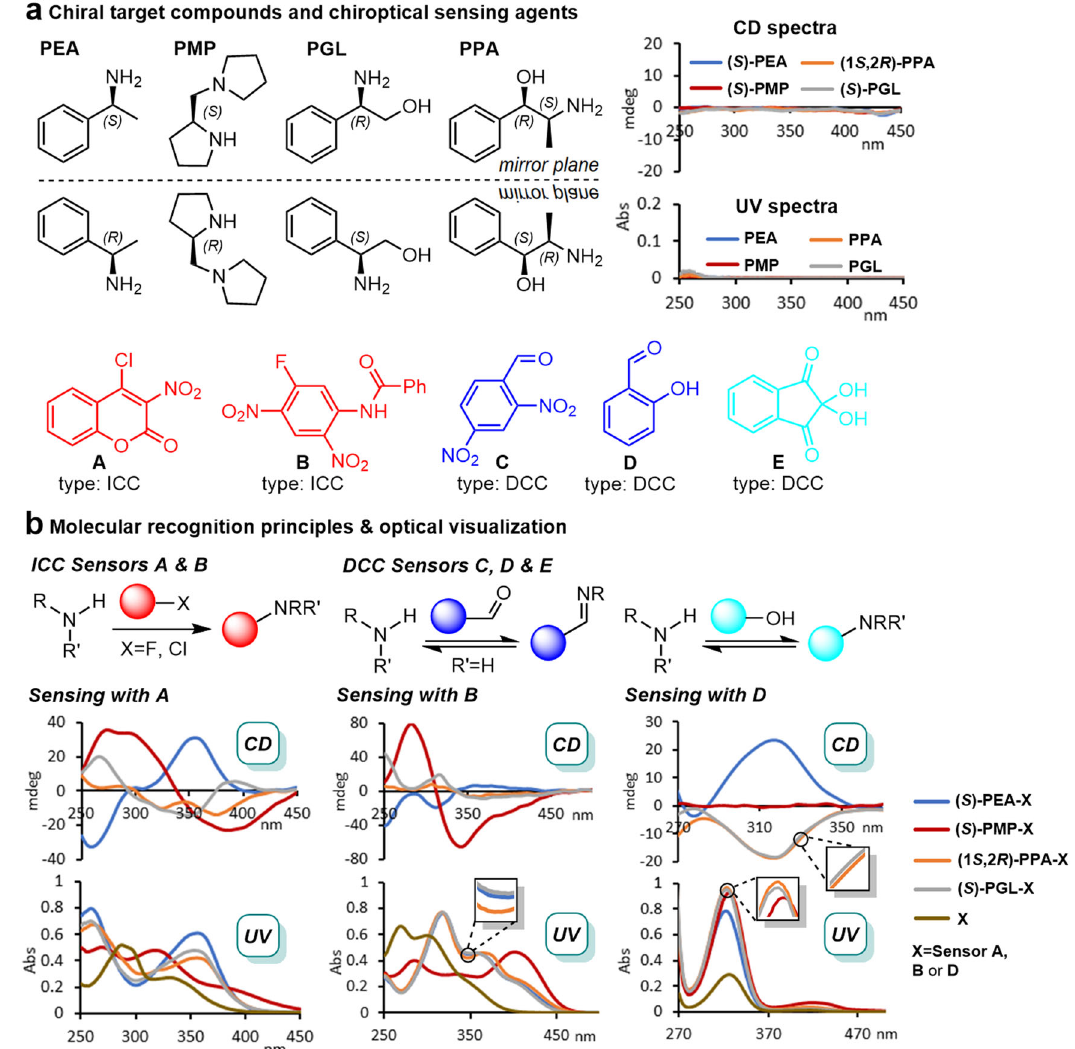
Fig. 1 Organic reaction-based chirality sensing. a Structures of the target compounds with inherently negligible optical activity. CD and UV spectra of ( S )- PEA , ( S )- PMP , ( S )- PGL and (1 R ,2 S )- PPA were recorded in 1,2-dichloroethane (DCE) at 0.125 and 0.083 mM, respectively. Chiroptical sensing agents operating based on irreversible covalent chemistry (ICC type) and dynamic covalent chemistry (DCC). b Molecular recognition principles and induced UV and CD spectra. Sensing with A : UV 0.094 mM, CD at 0.042 mM in DCE; B : UV 0.083 mM, CD at 0.021 mM in CHCl 3 ; D : UV 0.062 mM, CD at 0.125